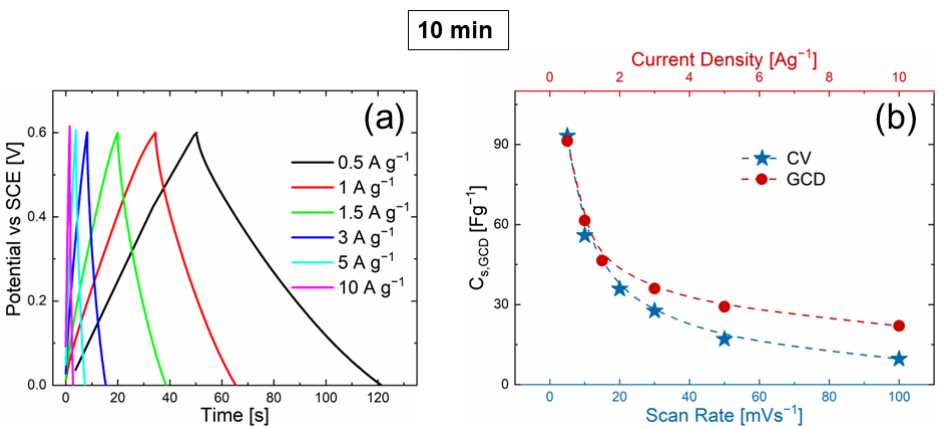
Figure 6. ( a ) GCD curves (0.5 A g − 1 black, 1 A g − 1 red, 1.5 A g − 1 green, 3 A g − 1 blue, 5 A g − 1 light blue, and 10 A g − 1 magenta lines) and ( b ) specific capacitance obtained by GCD (red dashed line and circles) and CV (light blue dashed line and stars) curves, trends of 10 min NS.